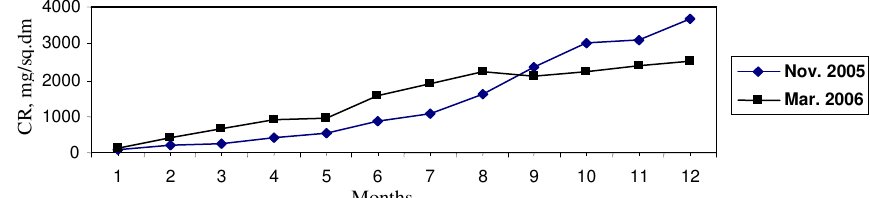
Figure 3. Progressive corrosion rate (CR) of mild steel under outdoor exposure at an urban atmosphere